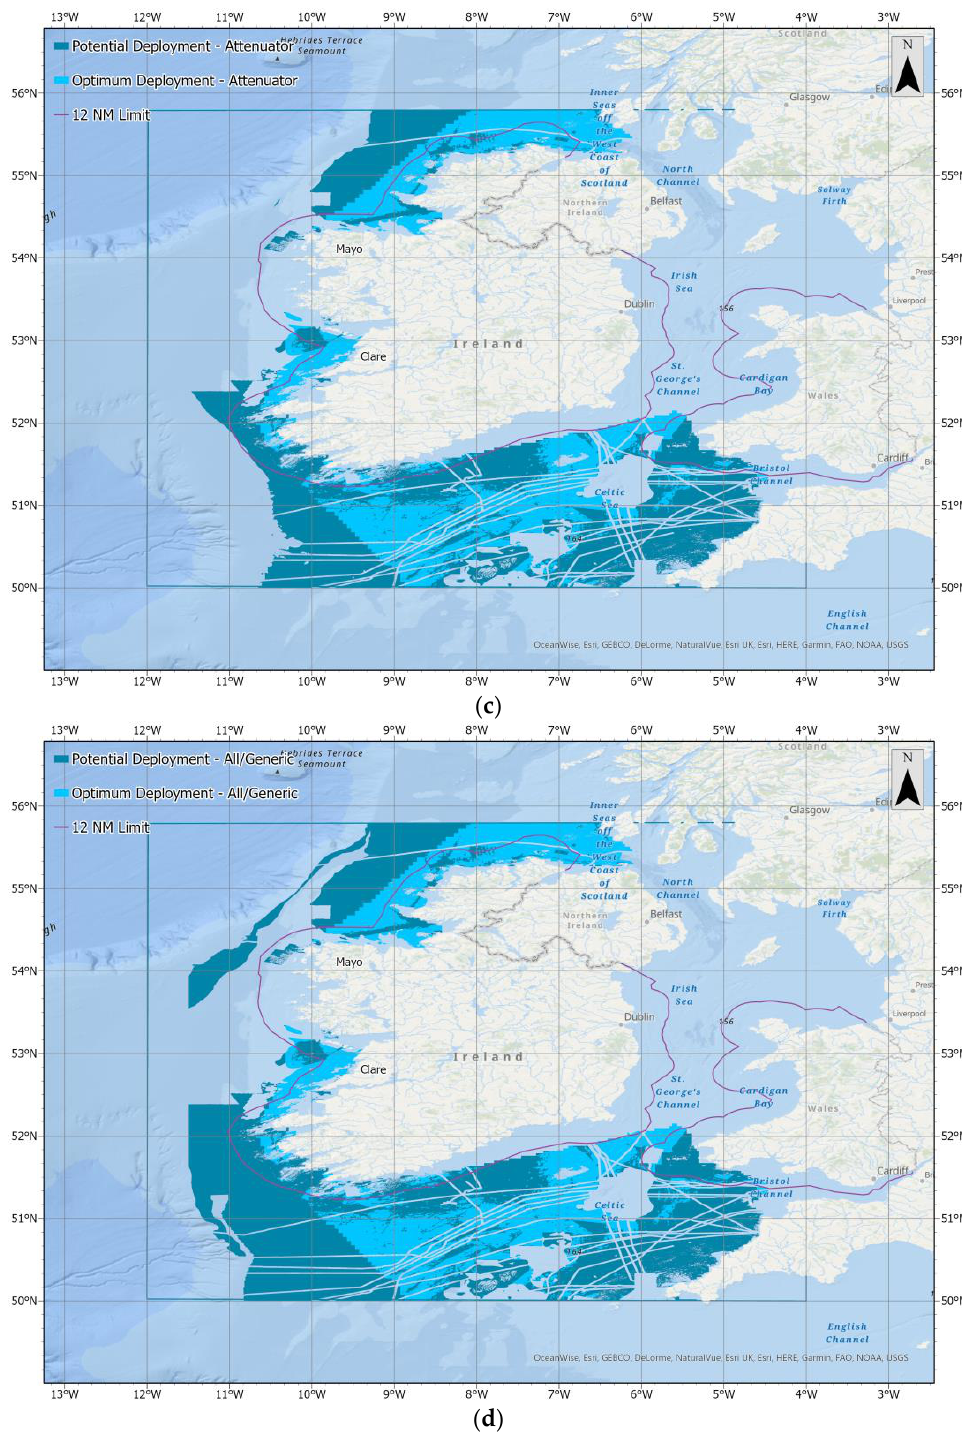
Figure 22. ( a ) Potential (dark blue) and optimum (light blue) sites for wave energy deployment based on survey responses from an OWC WEC technology developer. ( b ) Potential (dark blue) and optimum (light blue) sites for wave energy deployment based on survey responses from a Point Absorber WEC technology developer. ( c ) Potential (dark blue) and optimum (light blue) sites for wave energy deployment based on survey responses from an Attenuator WEC technology developer. ( d ) Potential (dark blue) and optimum (light blue) sites for wave energy deployment based on survey responses from all WEC technology developers.